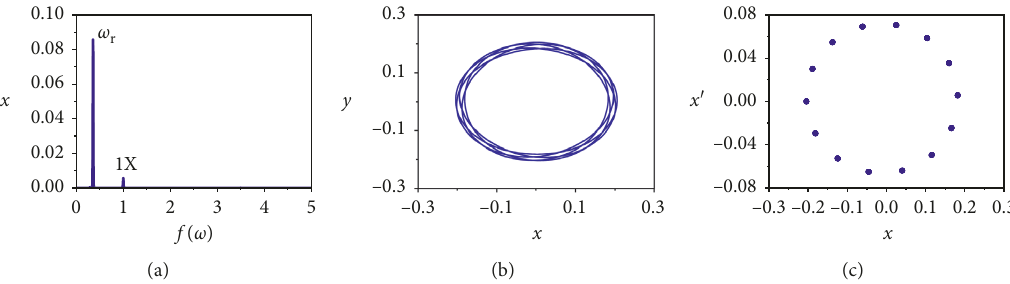
2.8. (a) The frequency spectrum of the x coordinate. (b) The orbit of the (cid:31)